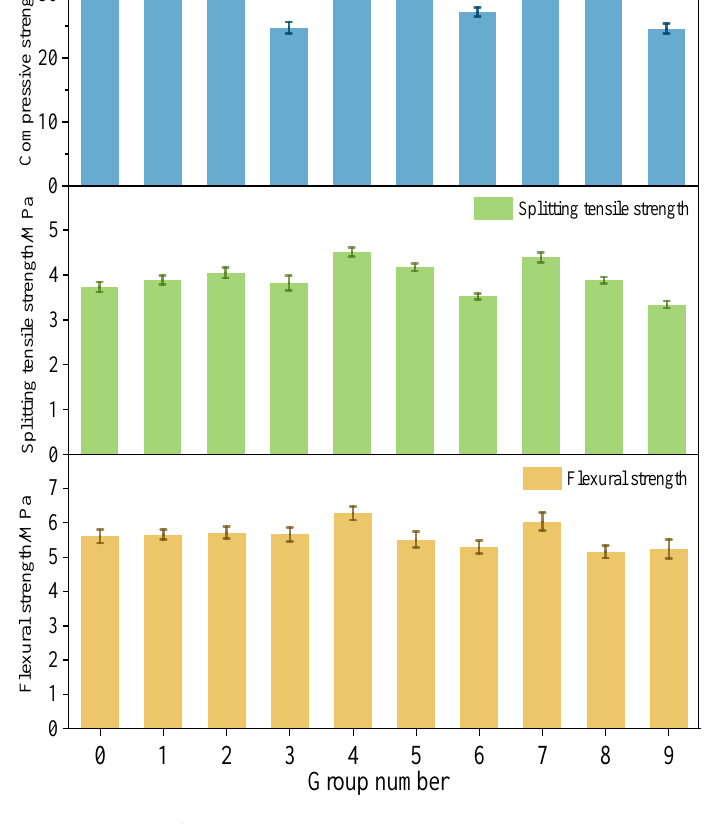
Figure 6. Strength. Figure 6. Strength.